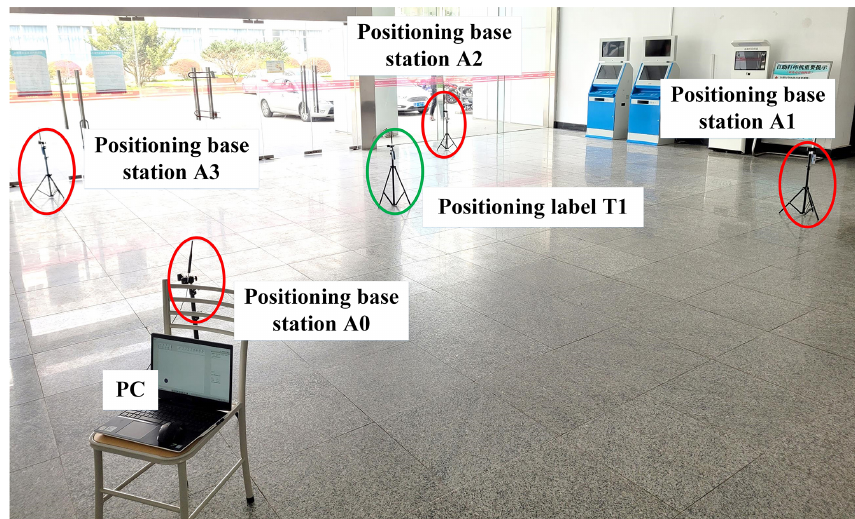
Figure 10. Positioning accuracy test.